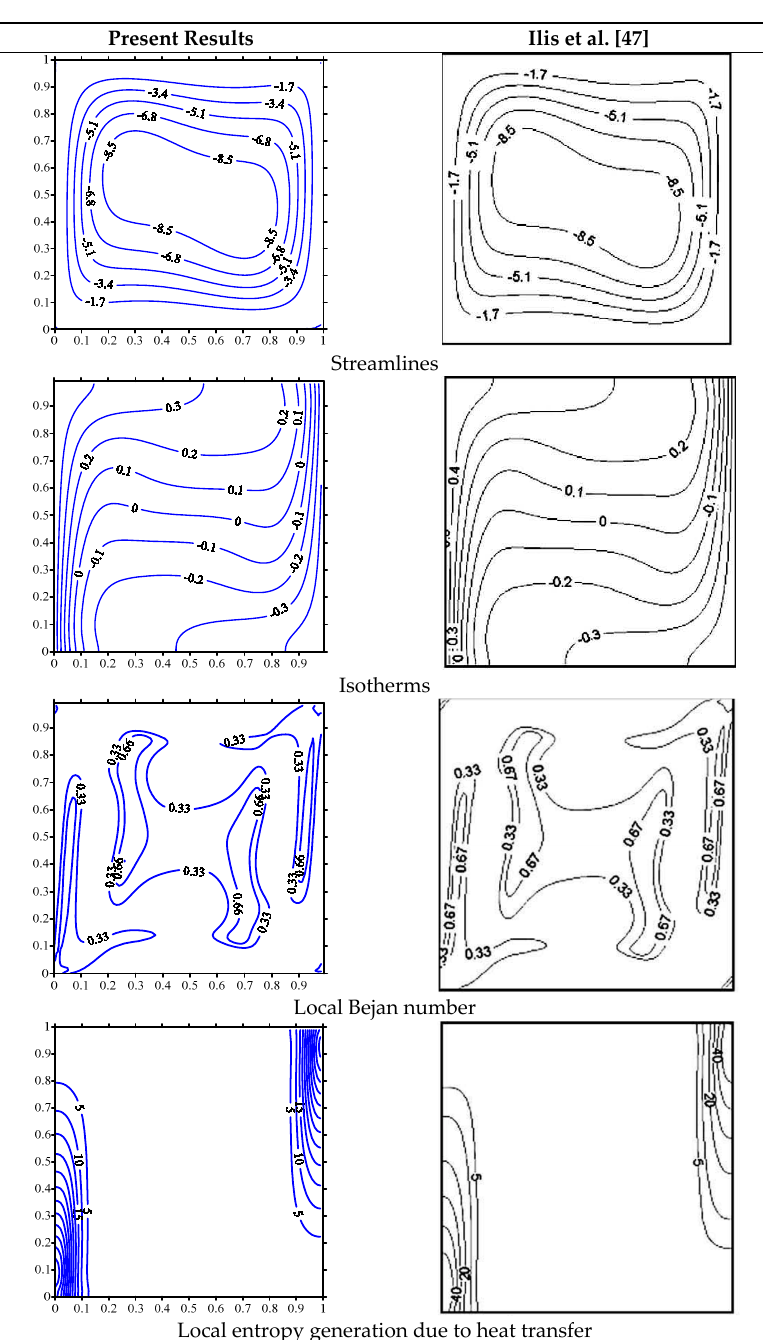
Figure 3. Comparisons of the streamlines, isotherms, local Bejan number and local entropy generation due to heat transfer with those of Ilis et al. [47] Pr = 0.71, Ra = 10 5 , ϕ 1 = 10 − 4